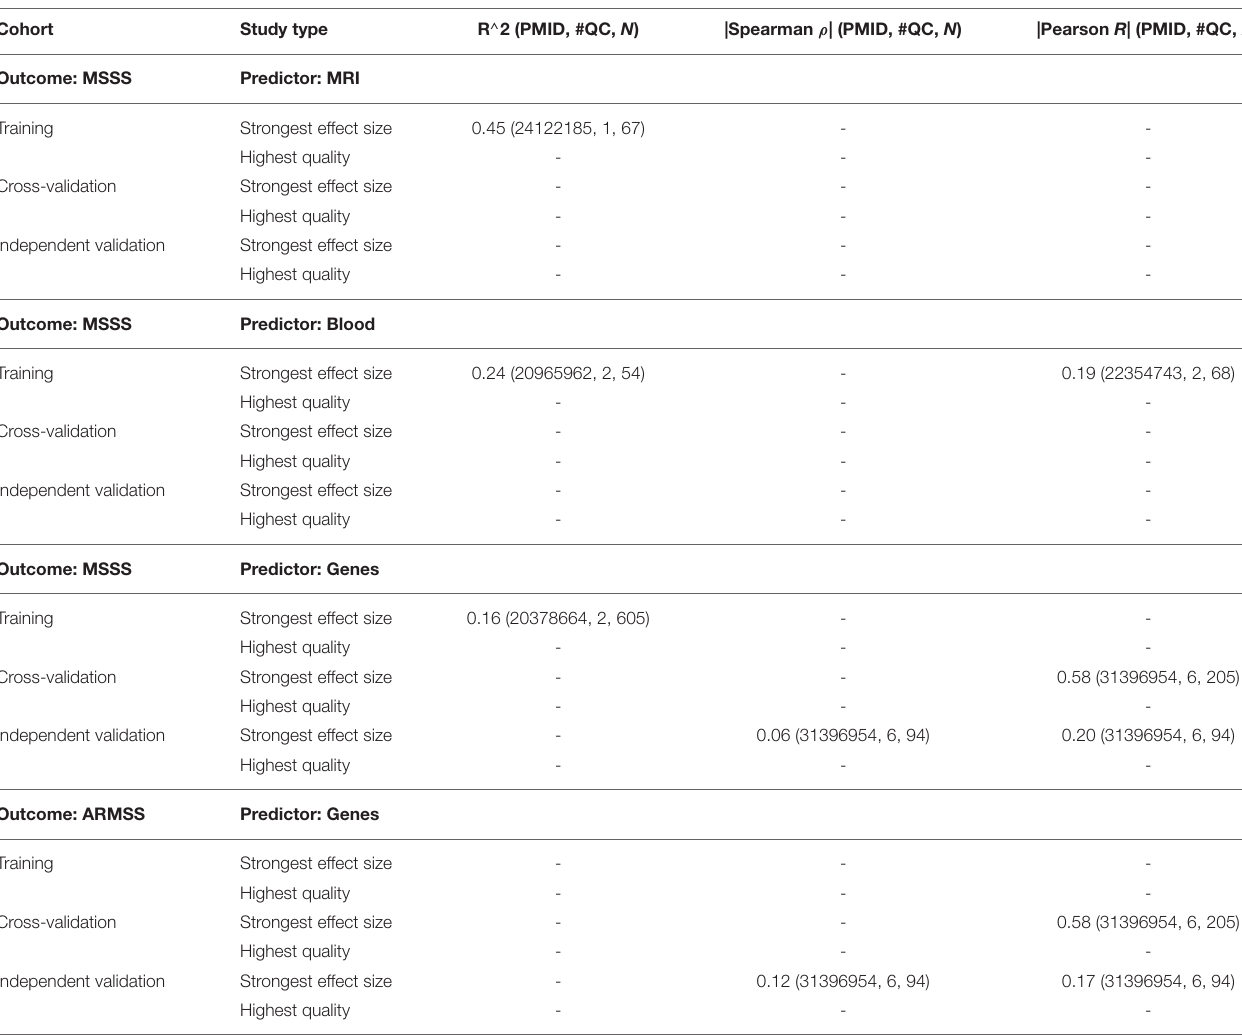
TABLE 2 | This set of tables includes EDSS-based multiple sclerosis (MS) severity outcomes MS Severity Score (MSSS) and age-related MSS (ARMSS), showing the studies that reported the highest effect sizes and those that achieved the highest technical quality, reporting R 2 , Spearman’s ρ , and Pearson’s R . Cohort Study